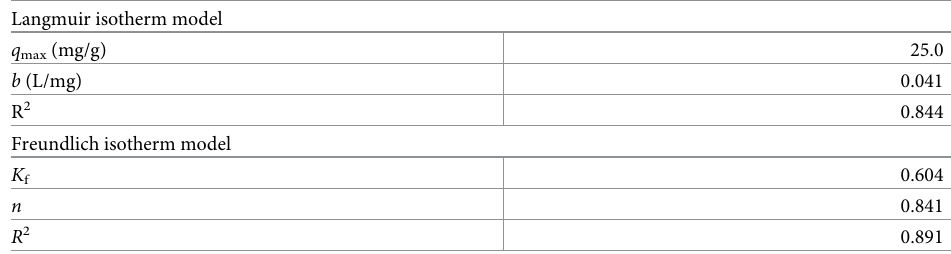
Table 3. Parameters of the isotherm models for fluoride adsorption using